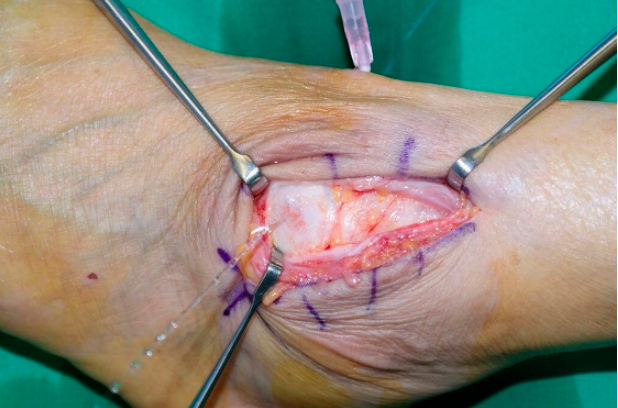
Figure 1. Saline leakage after saline loading into the ankle joint.